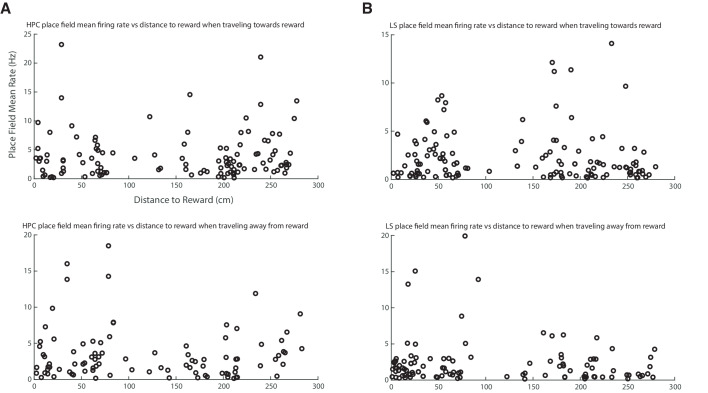
Mean place field firing rate is not correlated with distance to a reward site.(A) Top: Scatter plot of mean firing rate in HPC place fields seen when the animal is traveling toward reward, plotted against distance to reward. Bottom: Scatter plot of mean firing rate in HPC place fields seen when the animal is traveling away from reward, plotted against distance to reward. (B) Same as A but in the LS.